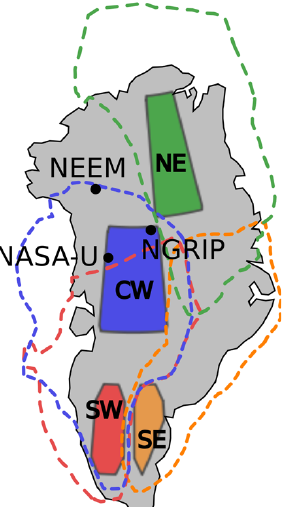
Fig. 2. Overview of the Greenland accumulation regions (shaded) as defined in Hutterli et al. (2005). The dashed contour lines denote regions that show a coherent accumulation behavior as the record of the corresponding region (significant correlation at 5% level based on t -test statistics in ERAi). The three dots indicate the locations of the NASA-U, NGRIP, and NEEM ice cores.